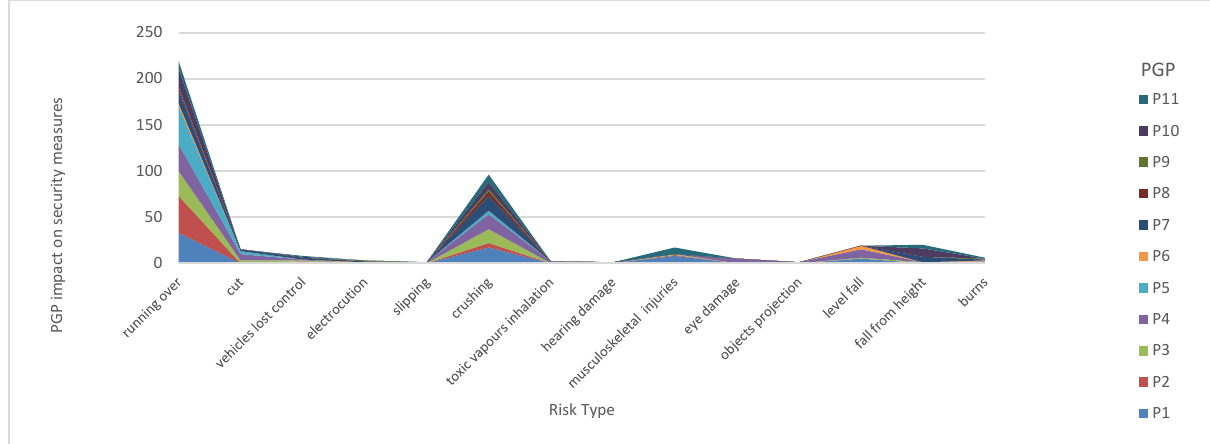
Figure 14. General prevention principles distribution associated to the